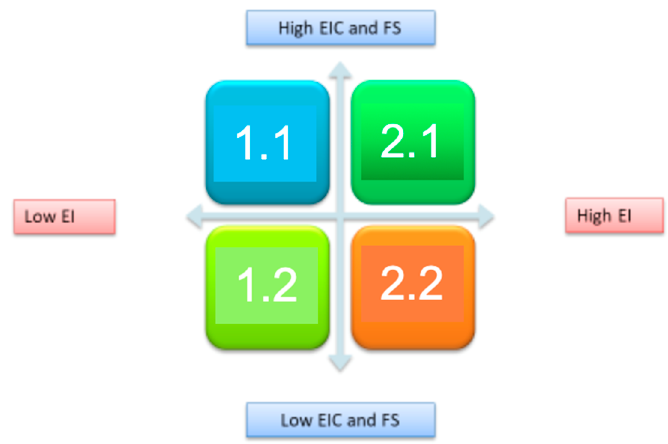
Figure 2. Representation of the average scores in EI, EIC, and family support (FS) in accordance with the groupings of the PCA projection.